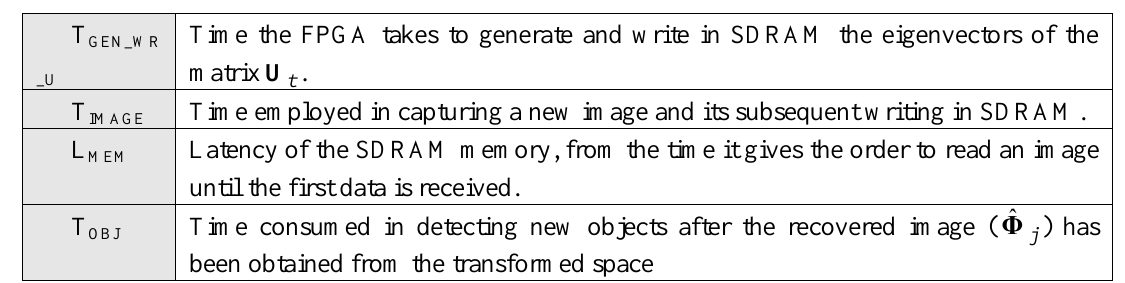
Table 1. Description of the partial times of T